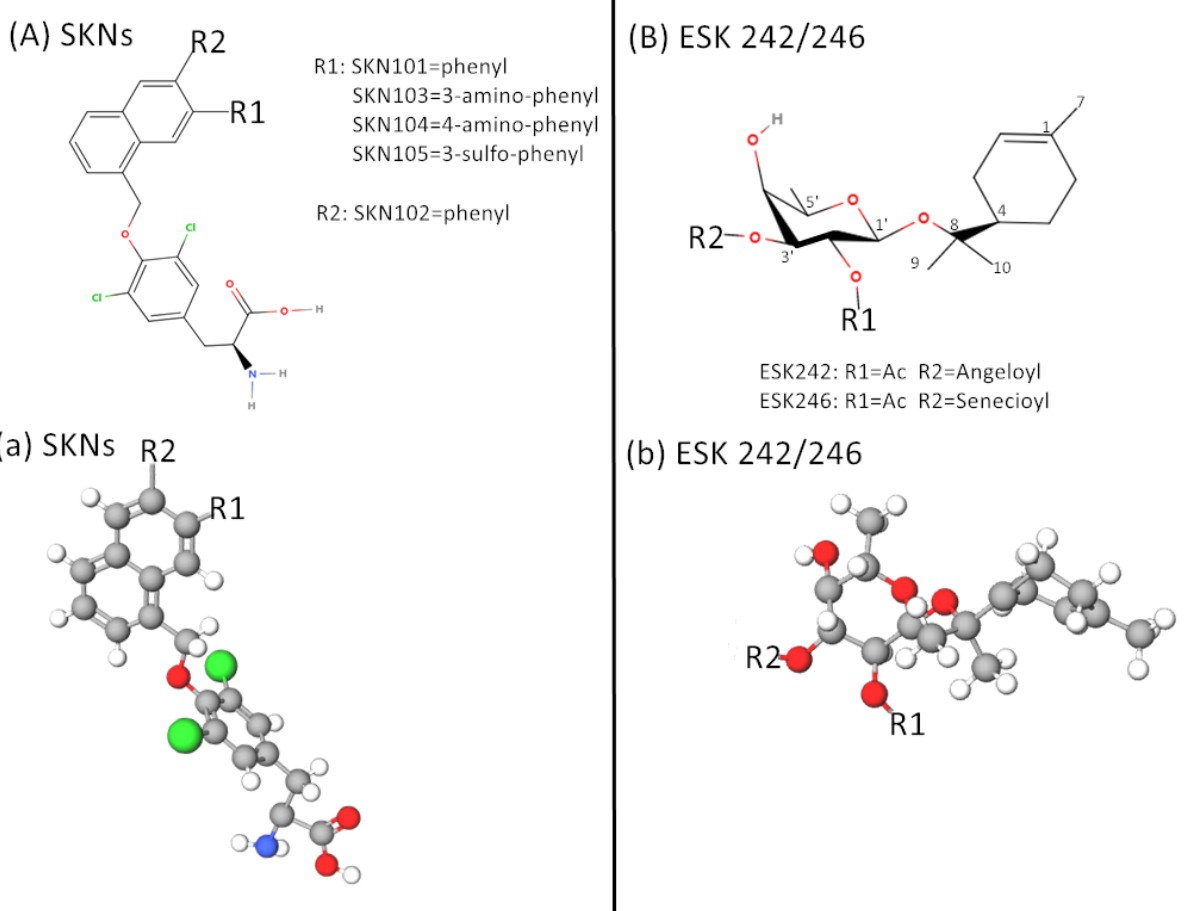
Figure 5. The 2D ( A , B ) and 3D ( a , b ) structures of LAT1 inhibitor SKN series and LAT3 inhibitor ESK series. ( Aa ) SKN series and JPH203 have similar molecular structures. ( B , b ) The ESK series shows a different molecular structure from LAT1 inhibitors such as T3, JPH203, and SKNs. ESK242 can inhibit both LAT1 and LAT3.